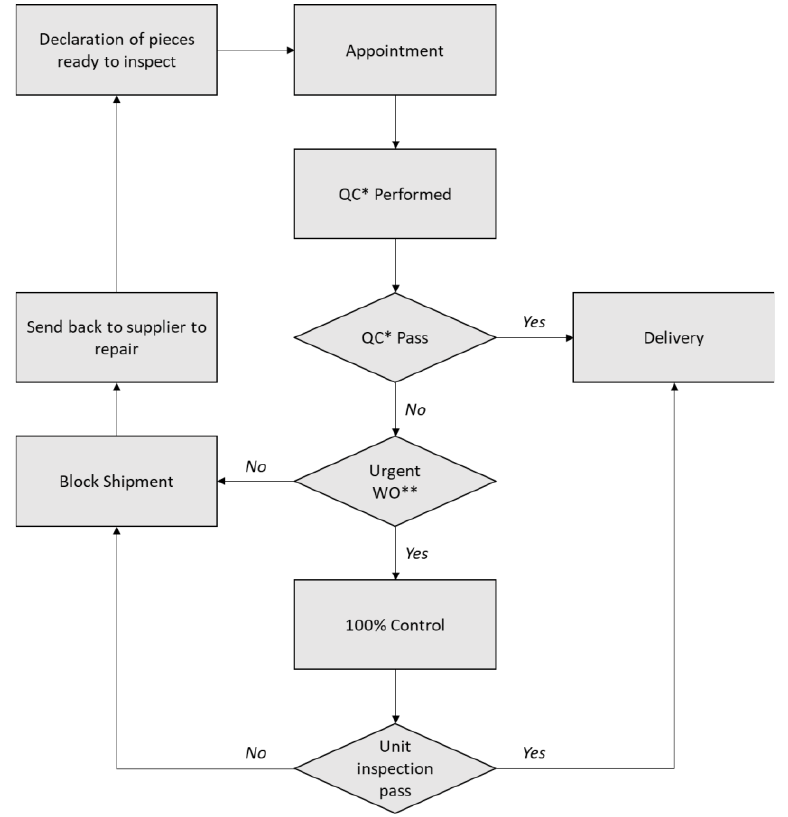
Figure 3. Quality control process for the analyzed company (* QC = Quality Control, ** WO = Work Order).